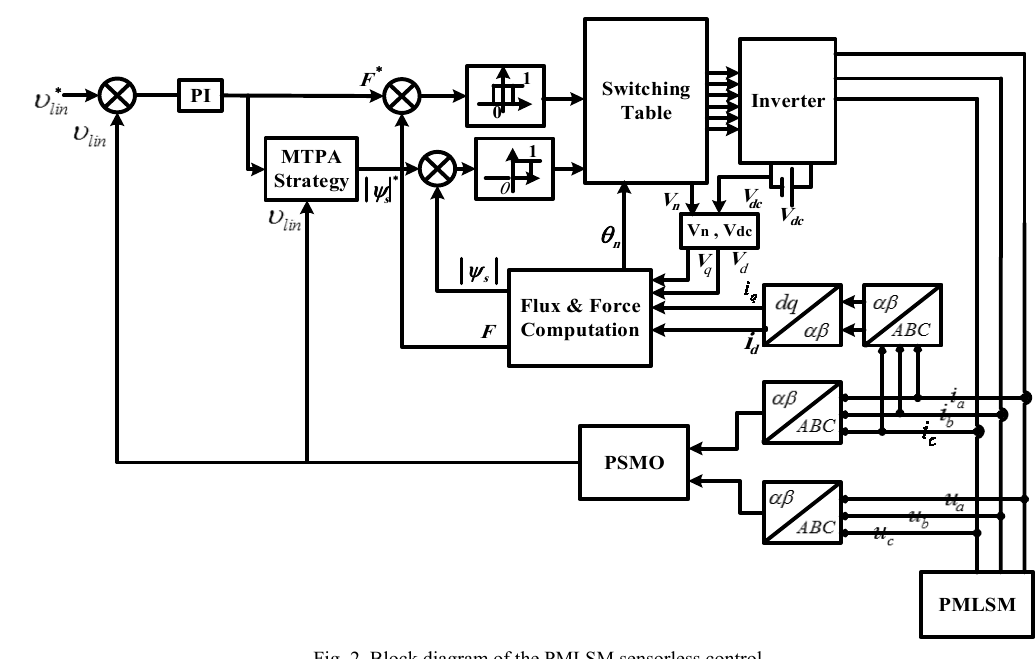
Fig. 2. Block diagram of the PMLSM sensorless control.